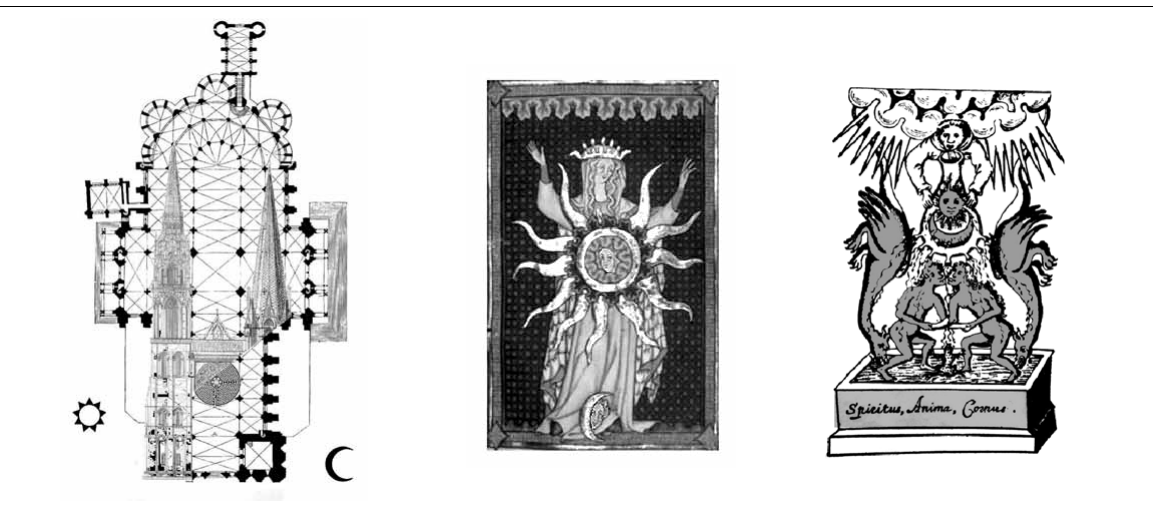
fig. 4. In scale manipulation of the plan and the main façade of Chartres Cathedral: if aligned, the oculus window matches the place of the pavement labyrinth. This feature could be dedicated to heighten the symbology of the apocalyptical Mary (middle) or to stress the contemporary belief of mystical composition of a human (on the right, treatise “ Theatrum Chemicum Britaniccum ” of 1652). Sources : http://en.wikipedia.org/wiki/Chartres_Cathedral; http://www.pinterest.com/pin/323414816961501654; Boczkowska